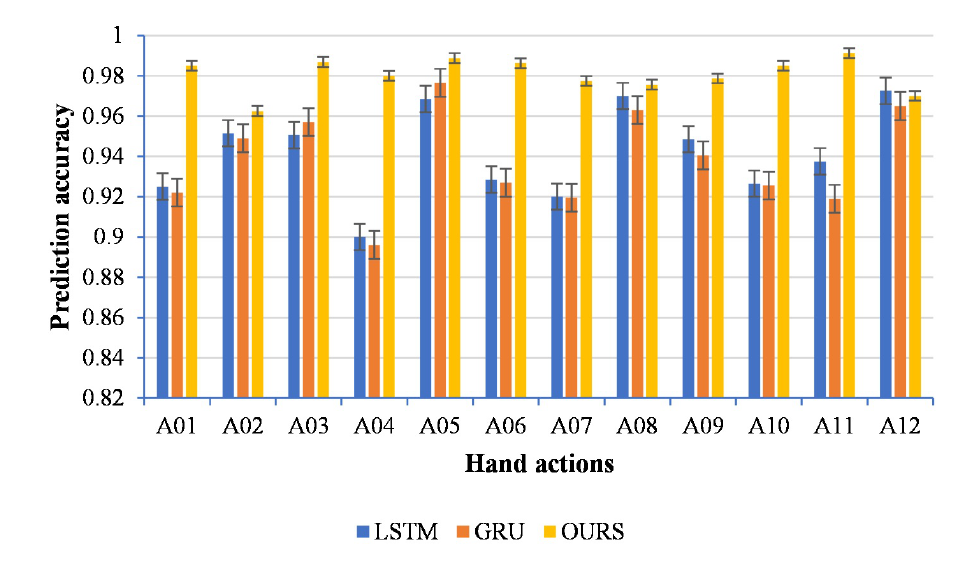
Figure 6. Hybrid test confusion matrix of all subjects with our method. N/G represents nongesture.